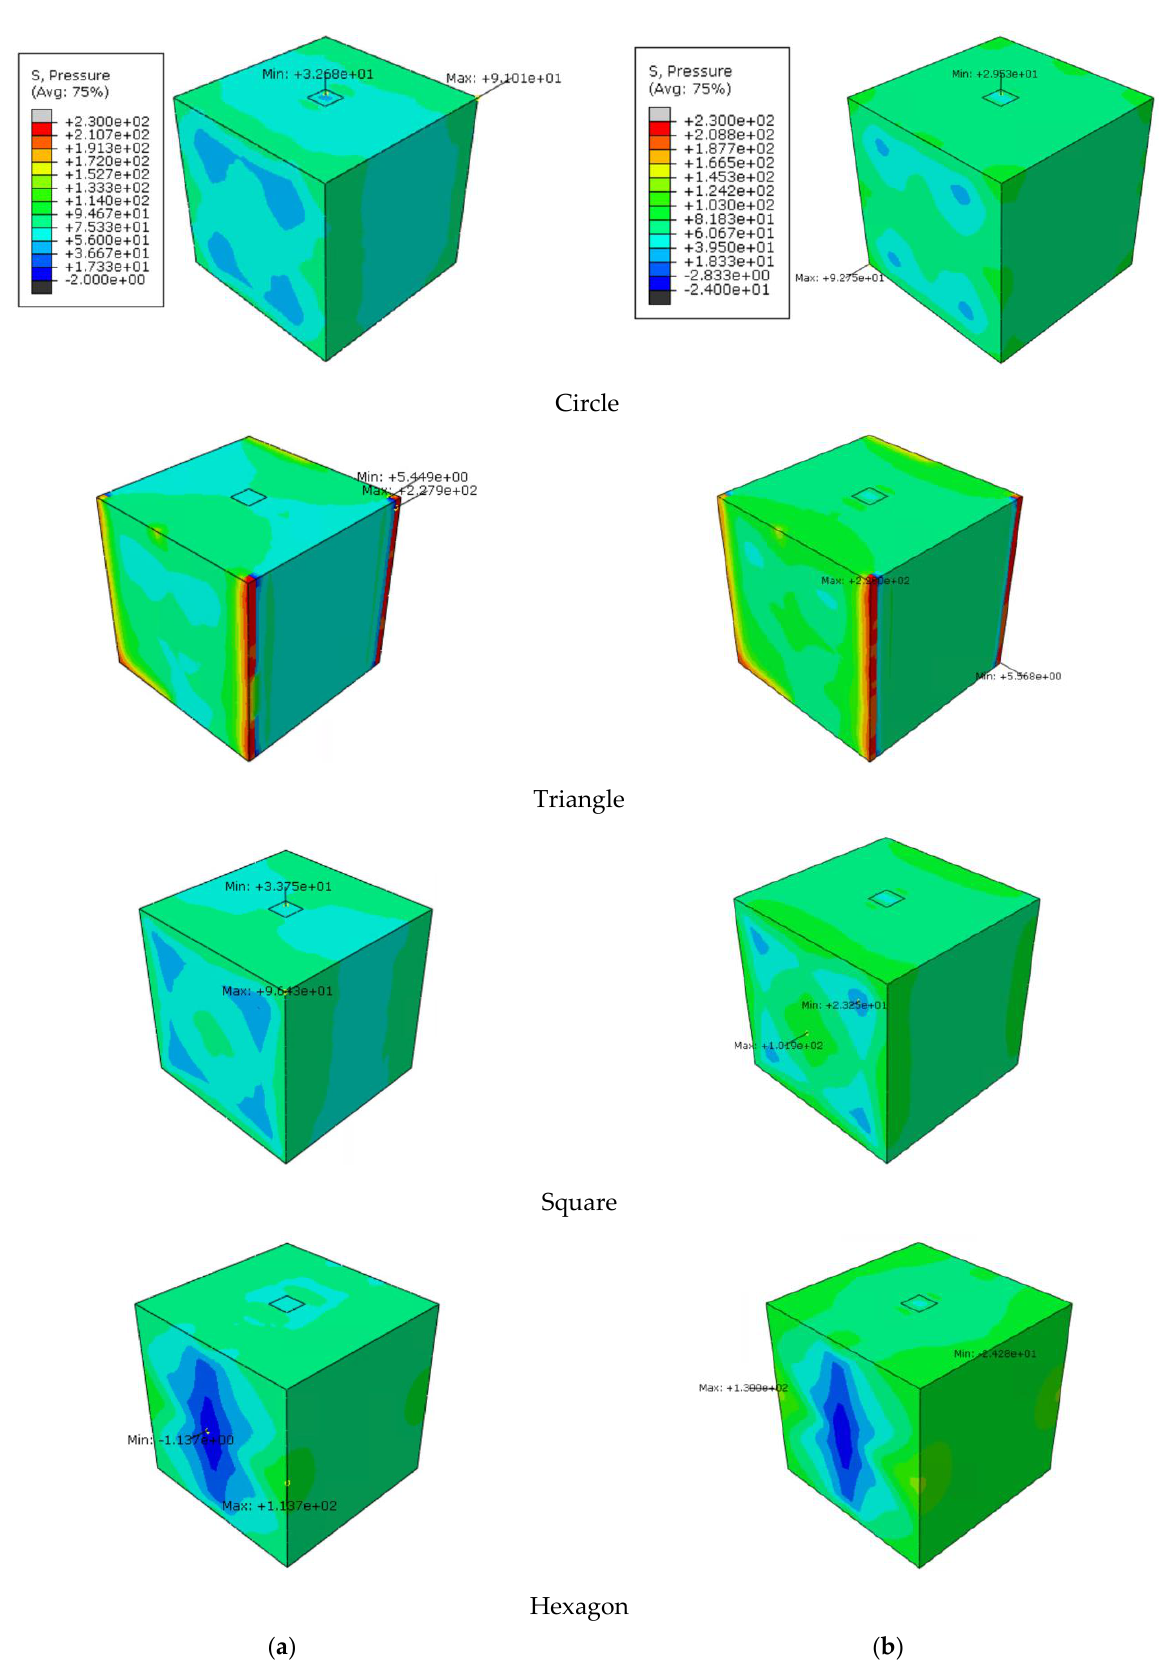
Figure 13. Pressure in the specimen at two increments of time. ( a ) t = 0.6 ms and ( b ) t = 0.7 ms